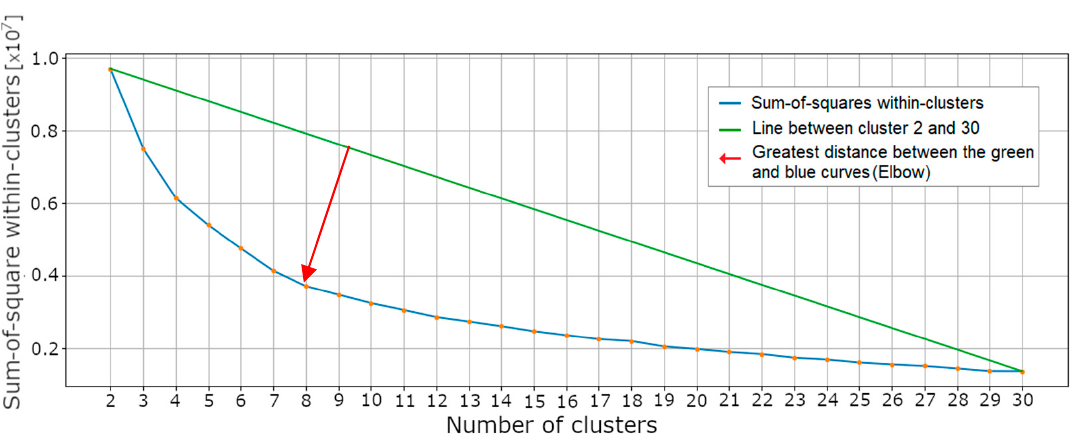
Figure 2. Within-cluster sum-of-squares curve resulting from the application of the elbow method, with the tested clusters varying from 2 to 30 and the “elbow” being identified in 8 clusters. The red arrow shows the best number of clusters, which is the greatest distance between the green and blue curves.